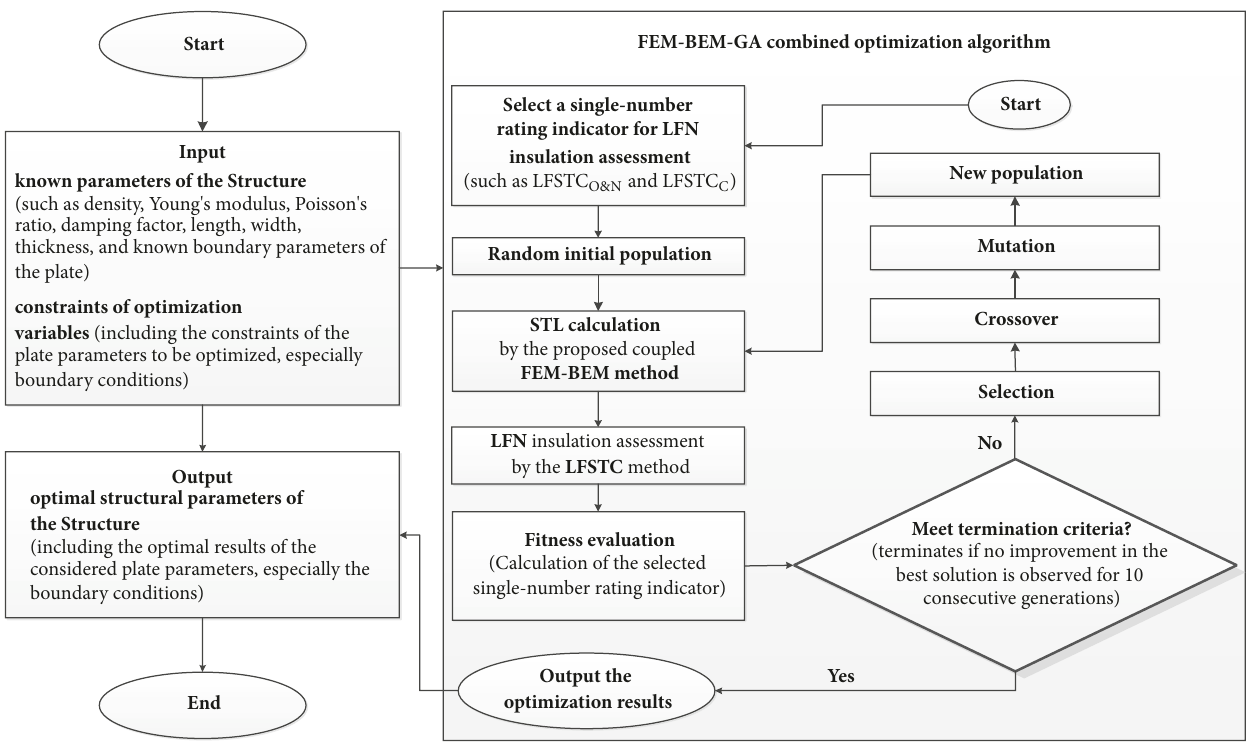
Figure 3: Flowchart of optimization